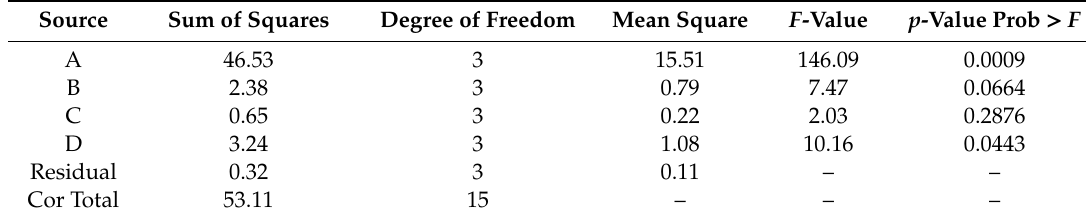
Table 5. ANOVA on S / N of cladding e ffi ciency.